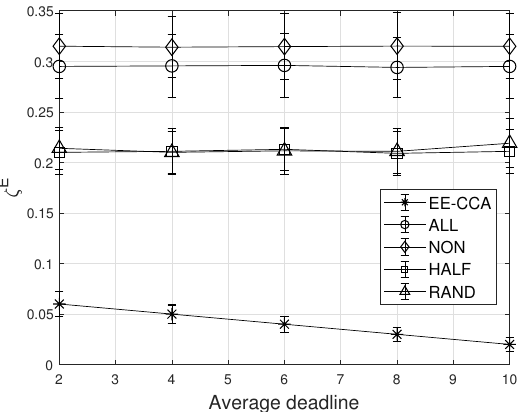
Figure 6. Effect of the average deadline of the